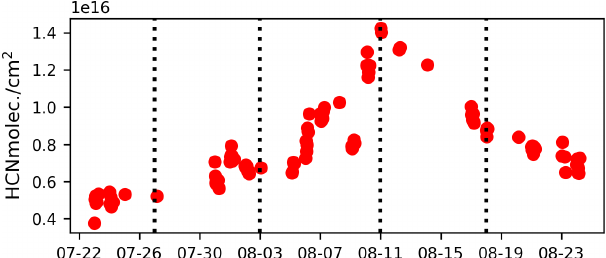
Figure 11. Time series of the FTIR HCN total column measure- ments at Xianghe between 22 July and 25 August 2021. A total of 4d of data (27 July, 4 August, 11 August and 18 August) are used to understand the air mass sources (see Fig. 12) and are marked with the dashed black